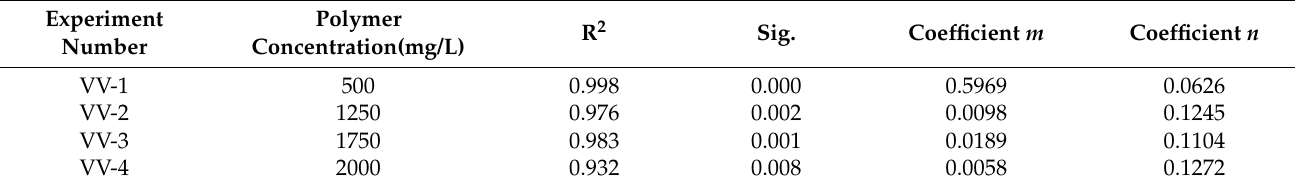
Table 3. Summary, ANOVA and coefficients of Formula (7) (Models are calculated by SPSS).